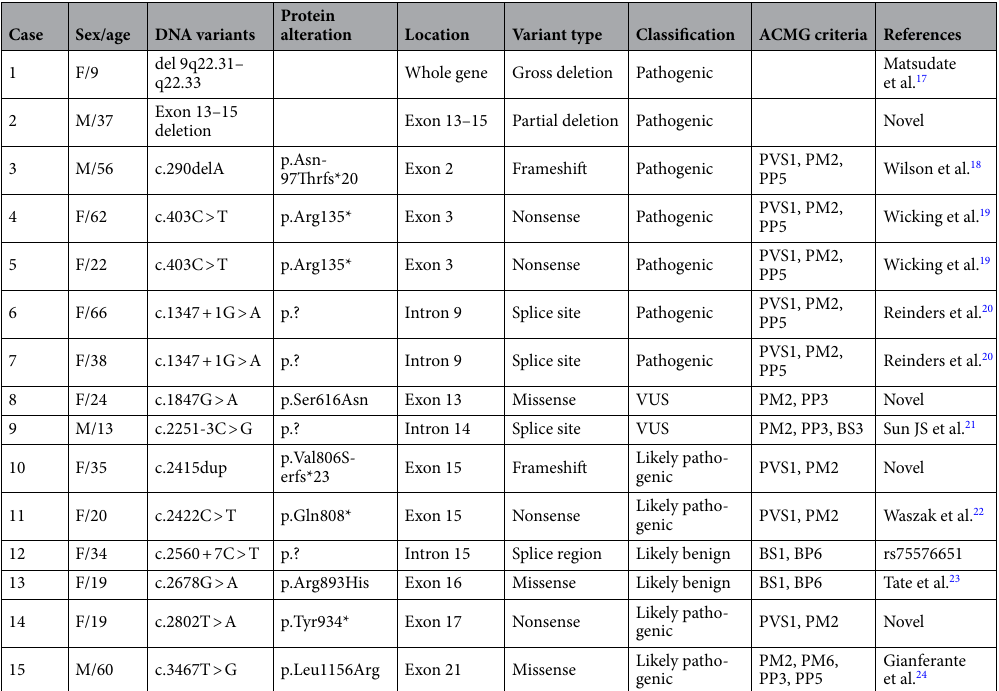
Table 2. PTCH1 variants of 15 NBCCS patients. VUS variant of uncertain significance, PVS pathogenic very strong, PM pathogenic moderate, PP pathogenic supporting, BS benign strong, BP benign